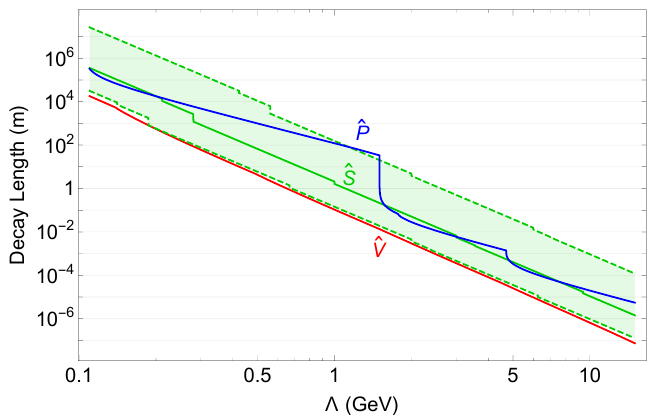
Figure 1 . Decay length of the lightest hidden mesons as a function of the con(cid:12)nement scale. We assume m ^ = 2(cid:3), (cid:22) = (cid:3) and vary (cid:3) = 2 < (cid:1) m < 3(cid:3) = 2 (green-shaded region) where P; ^ V (cid:1) m (cid:17) m ^ (cid:0) m ^ . The solid green curve corresponds to (cid:1) m = (cid:3). The scale M is (cid:12)xed to 2 TeV; S V the lifetimes for di(cid:11)erent M are obtained from the scaling c(cid:28) / M 4 . The plot depends very